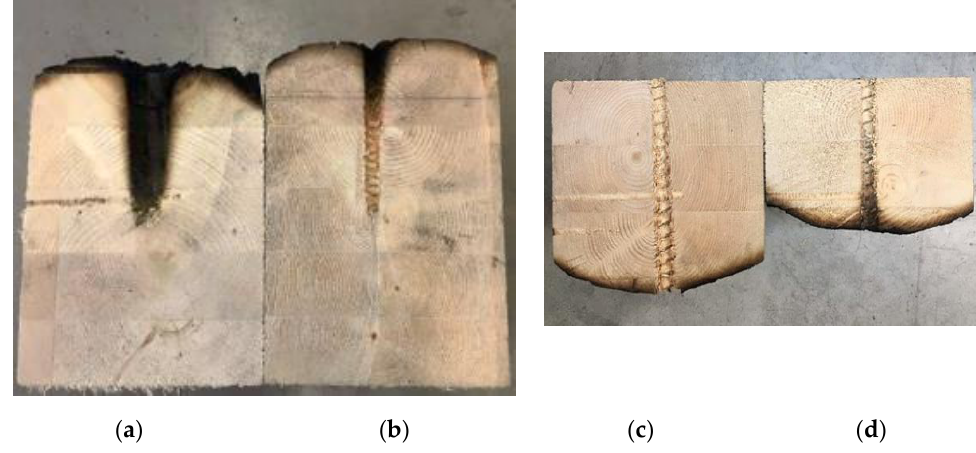
Figure 9. Charring of fastener under constant heat flux; ( a ) Unprotected Ø15.9 × 140 mm bolt head exposed for two hours; ( b ) Unprotected Ø10 × 160 mm screws head exposed for two hours; ( c ) Protected Ø10 × 160 mm screws (tip exposed) for one hour; ( d ) Protected Ø10 × 160 mm screws (tip exposed) for two